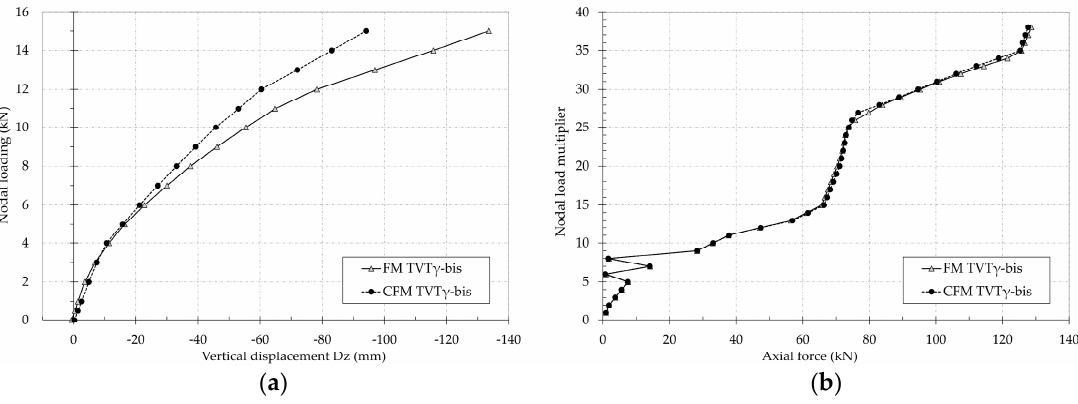
Figure 14. Comparison between the FM TVT γ -bis and the CFM TVT γ -bis: ( a ) nodal load vs. mid-span deflection; ( b ) nodal load vs. axial force in the lower strand.